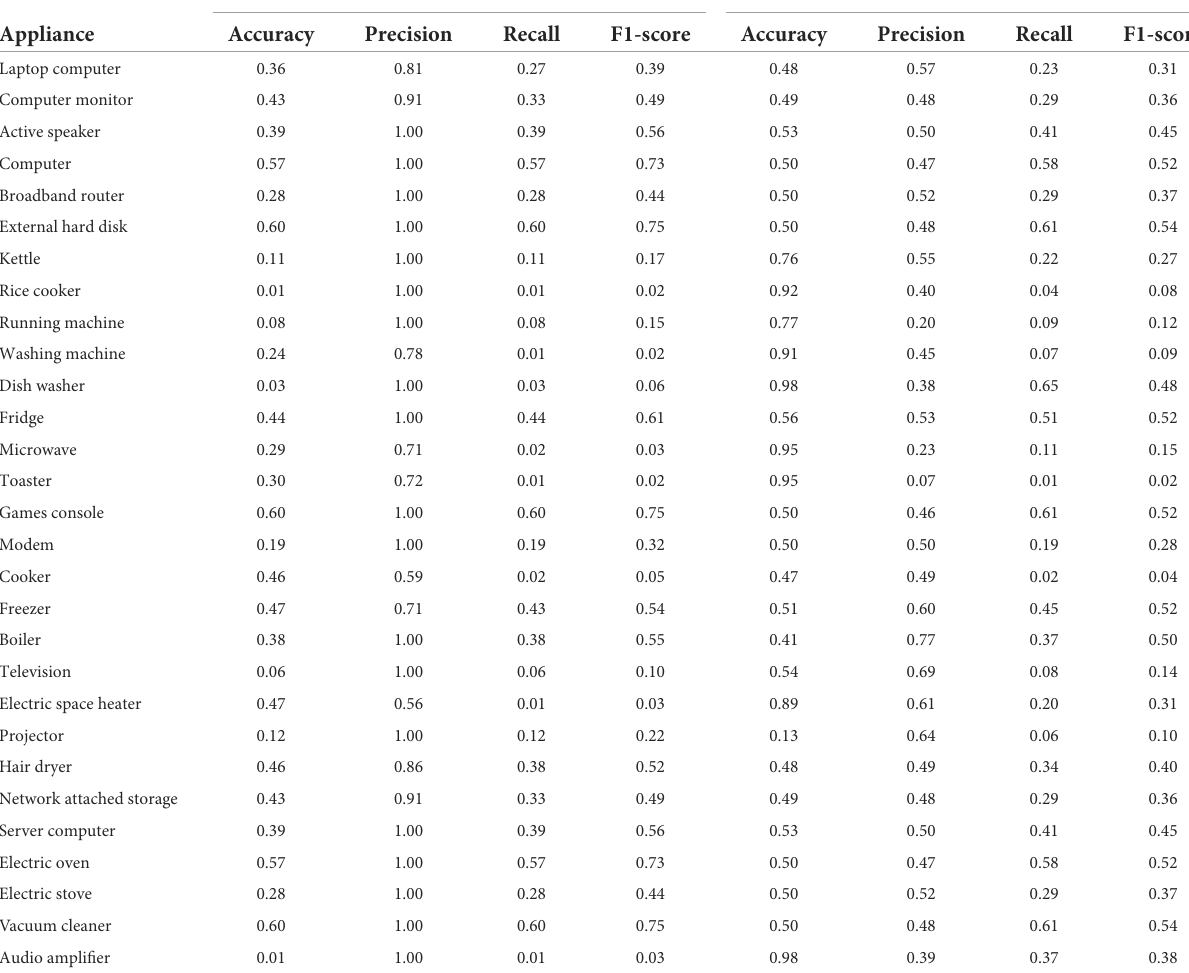
TABLE 5 NILM method performance in predicting the on/off status per